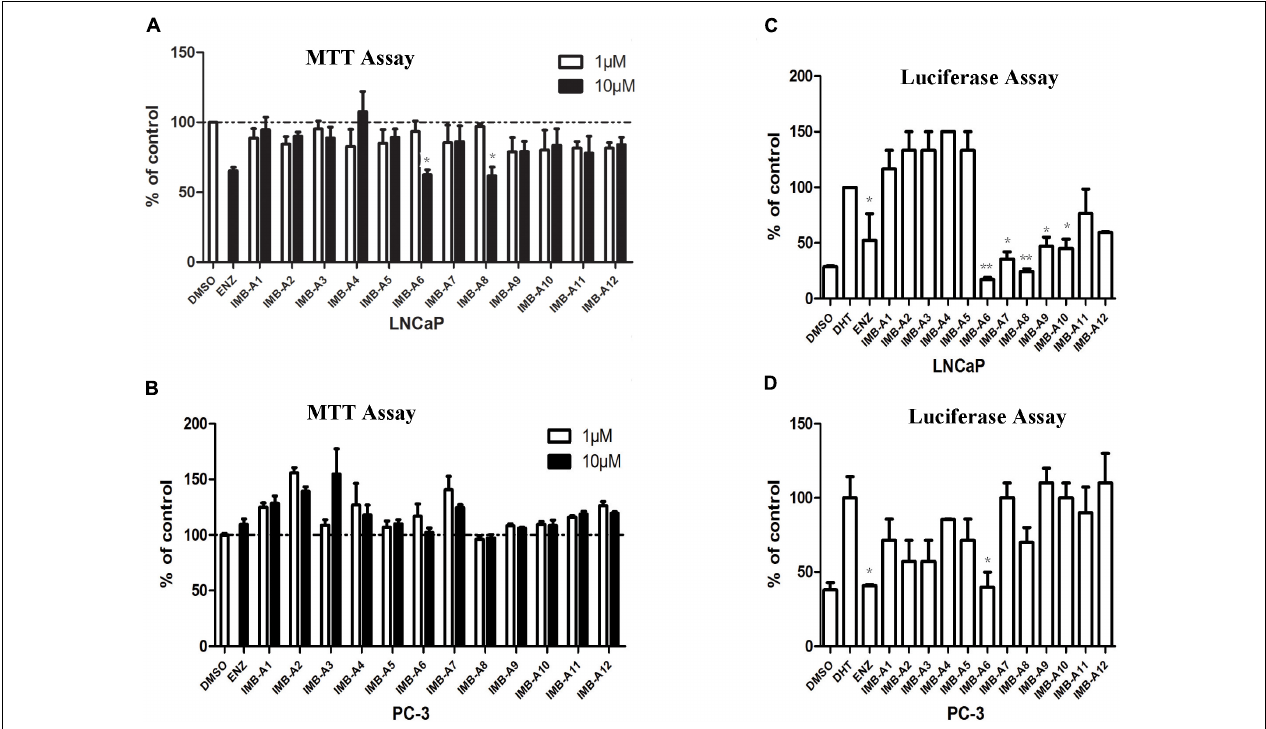
FIGURE 2 | The biological evaluation of candidate compounds. (A) MTT assay of candidate compounds in the LNCaP cells. (B) MTT assay of candidate compounds in the PC-3 cells. (C) The dual-luciferase assay of AR activity for candidate compounds in LNCaP cell. (D) The dual-luciferase assay of AR activity for candidate compounds in LNCaP cell. Experiments were in triplicate. All results are shown as mean ± s.d. ∗ P < 0.05, ∗∗ P < 0.01 vs. DMSO group (MTT assay) or DHT group (dual-luciferase assay). ENZ, enzalutamide; DHT, dihydrotestosterone.